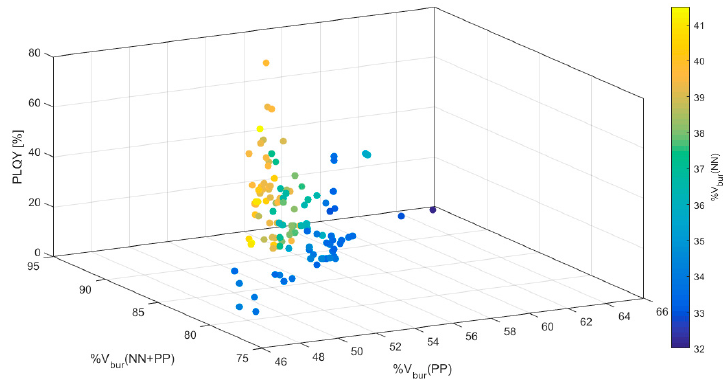
Figure 3. 3-Dimensional scatter plot with color-coded %V bur (NN) of all 100 compounds found in the Cambridge Structural Database (CSD) (Table S1, Supplementary Materials) [17–21, 23–27,30–48].